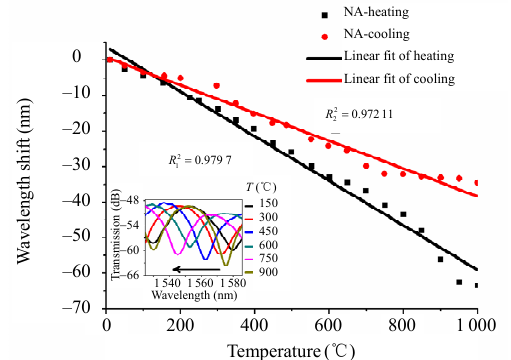
Fig. 7 Wavelength shift versus temperature for the FMF